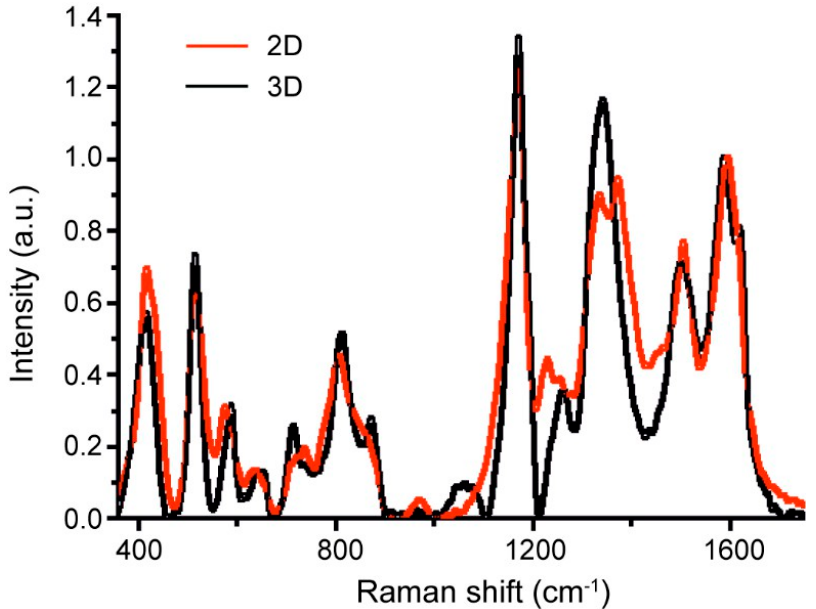
Figure 2. Raman spectra of PANI on 2D and 3D substrates (cover slips and AAO membranes, respectively). The morphology of PANI structures determines the sample surface area that is of characterized by SEM directly after removal from the polymerization zone (Figure 3a).